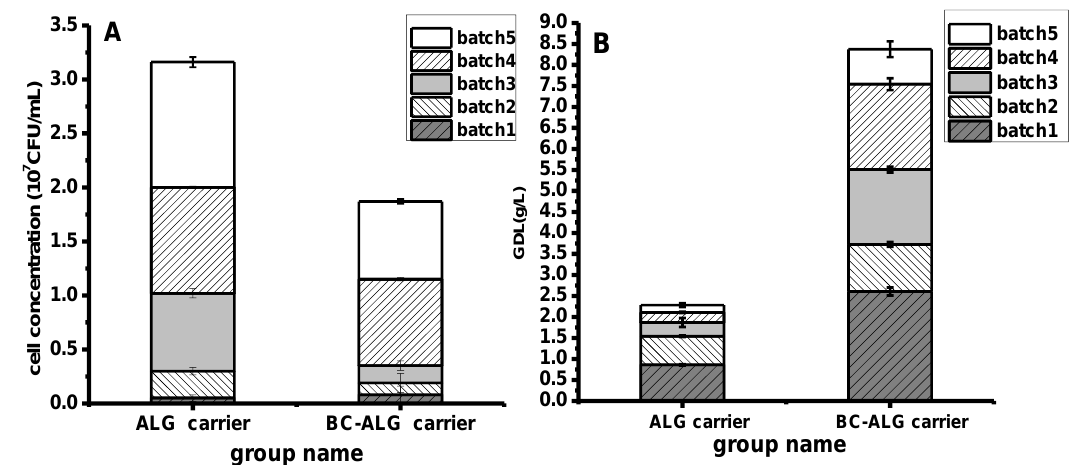
Figure 2. Comparison between medium with ALG and BC-ALG carriers in terms of cell leakage ( A ) and GDL yield ( B ) over 5 repeated-batch biotransformation experiments.